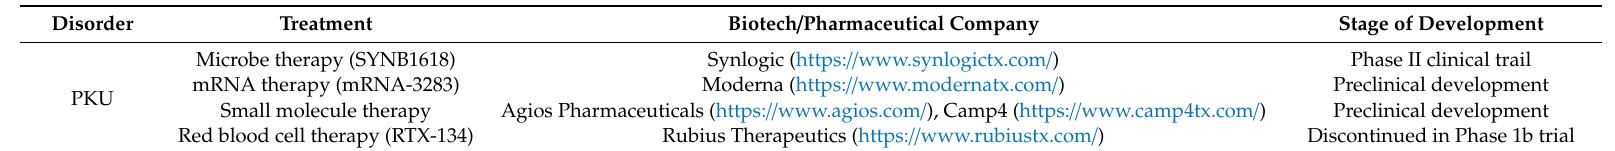
Table 2. Emerging trends in PKU